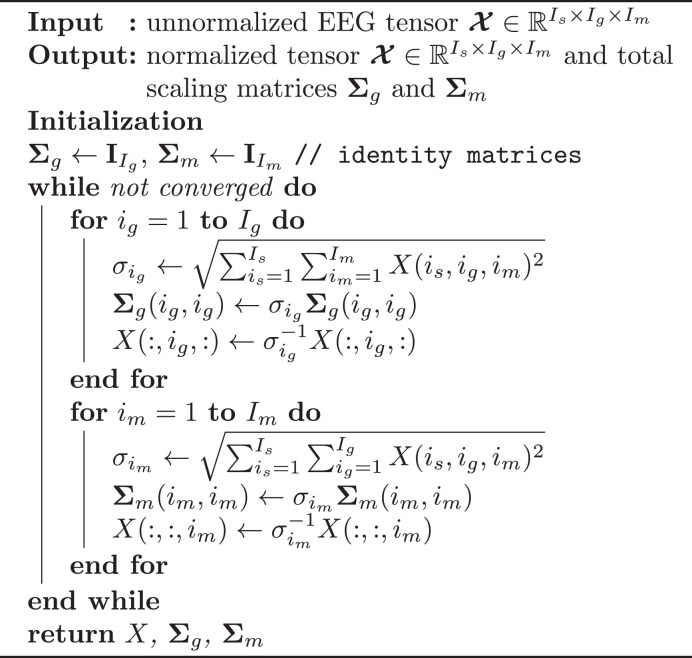
Tensor scale normalization